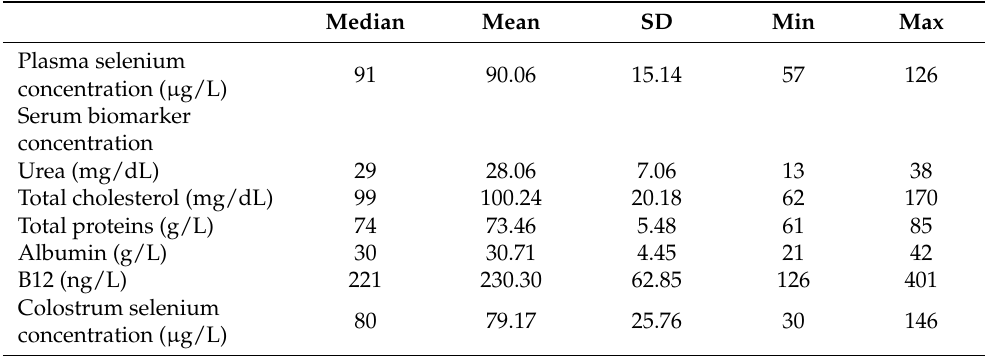
Table 2. Descriptive statistics of plasma selenium, serum biomarkers and colostrum selenium